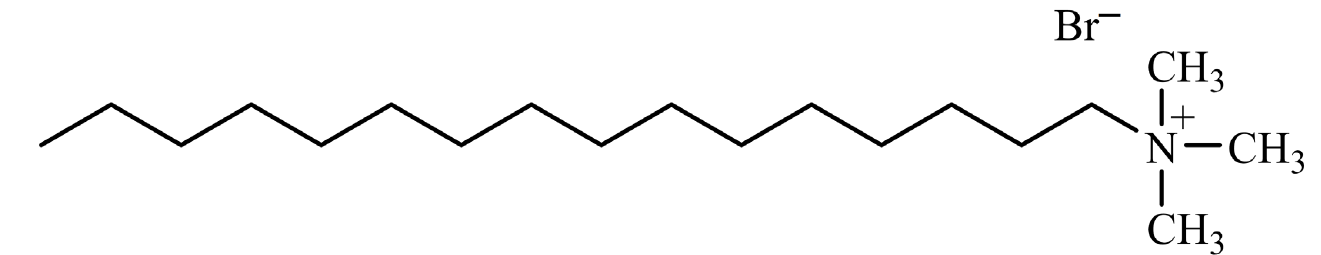
Figure 1. The chemical structure of CTAB.